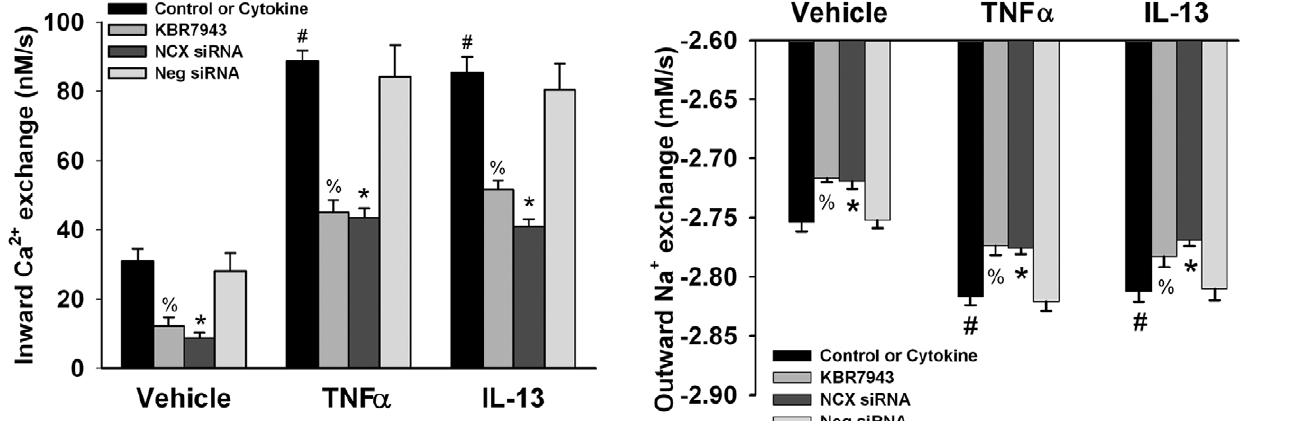
(Figure 3; reflecting Na + influx potentially through different mechanisms including outward Ca 2 + exchange mode NCX).